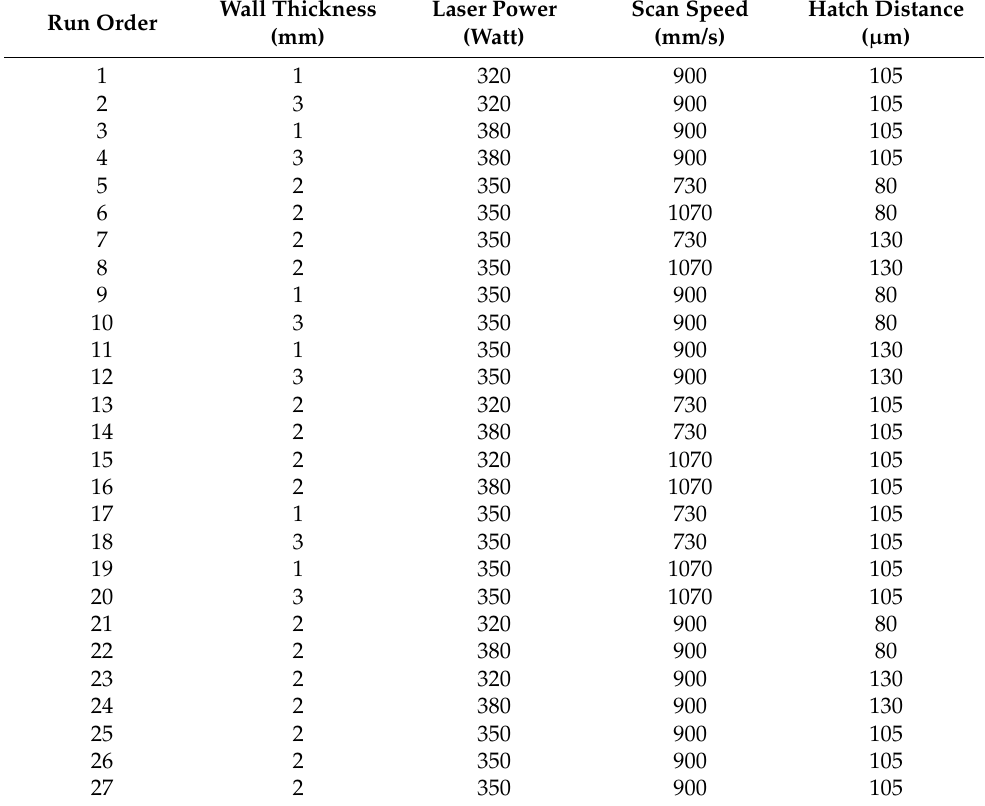
Table 3. Four-factor three-level Box–Behnken